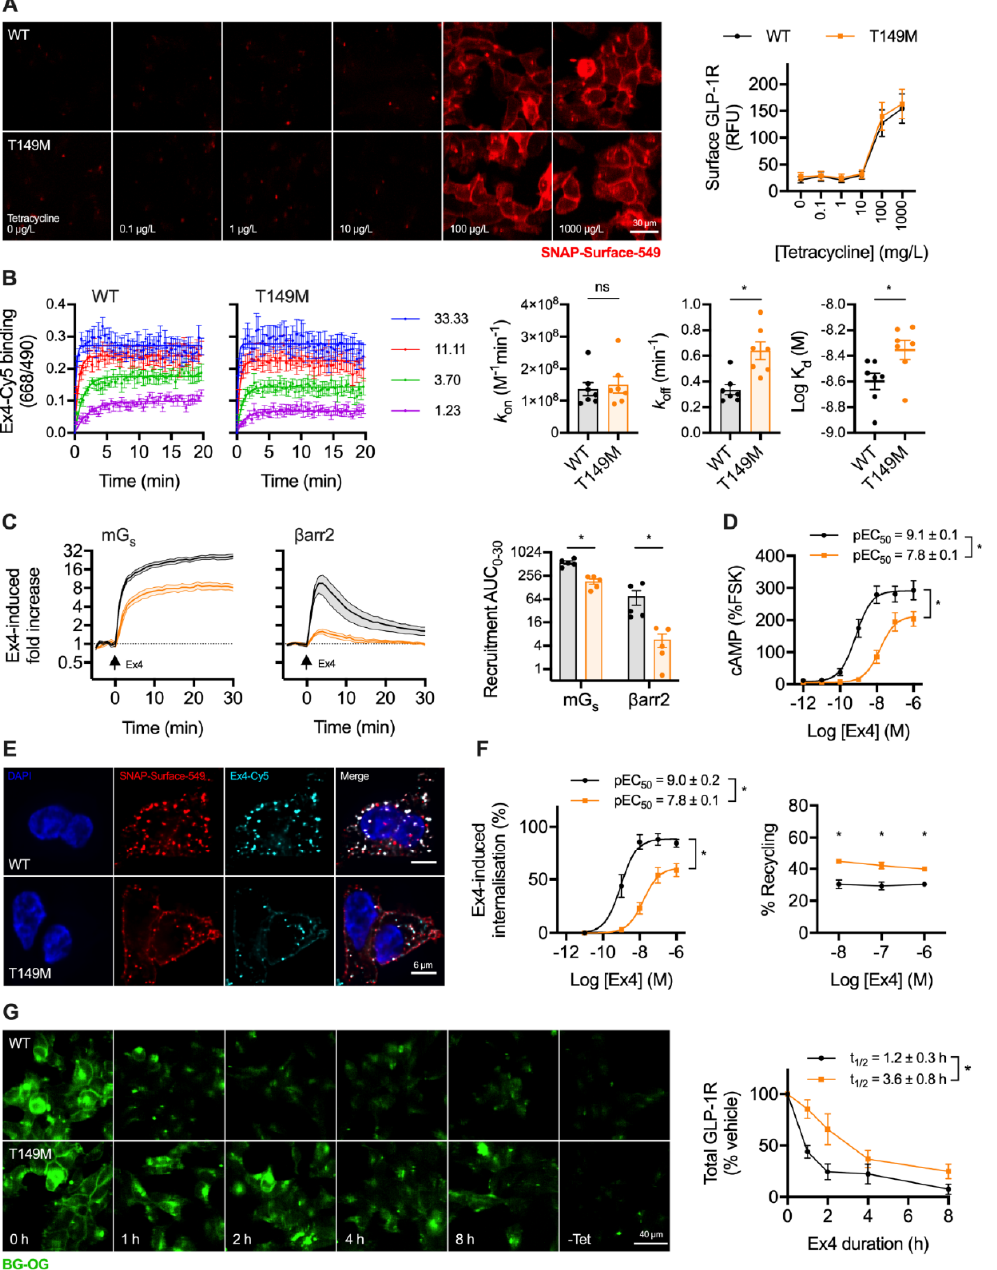
Figure 4. Trafficking and signalling with the T149M GLP-1R variant. ( A ) Tetracycline-induced expression of wild-type and T149M SNAP-GLP-1R in stably transfected Flp-In 293-T-REx cells, with quantification from n = 5 experiments; scale bar = 30 µm. ( B ) Assessment of kinetic binding parameters of exendin-4-C39-Cy5 in 293-T-Rex-GLP-1R cells, n = 7, with comparisons by paired t -test. ( C )